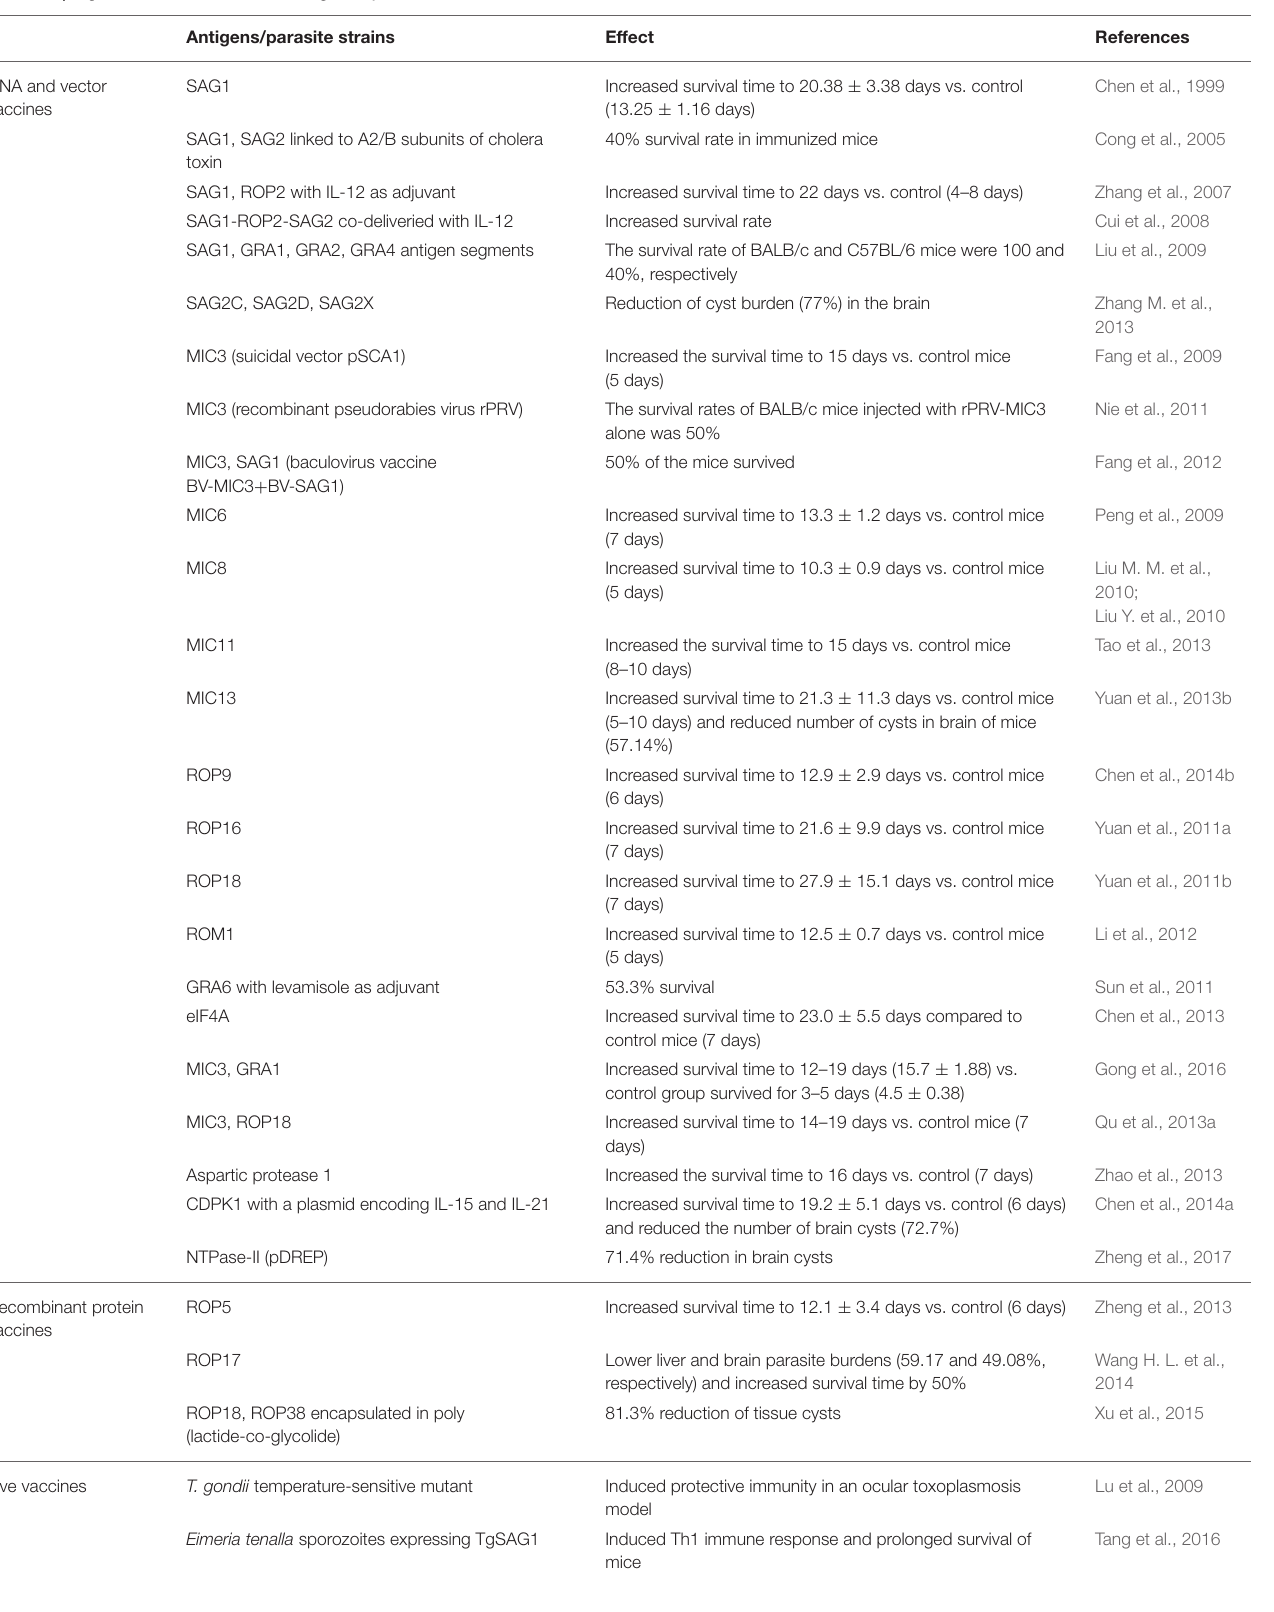
TABLE 3 | T. gondii vaccine candidates designed by scientists in